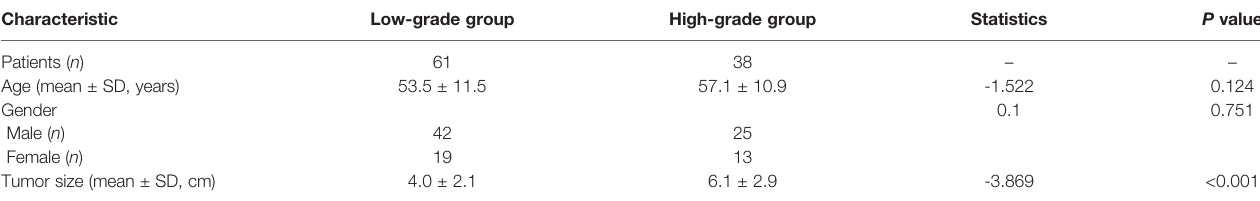
TABLE 1 | Analysis of baseline data from patients with